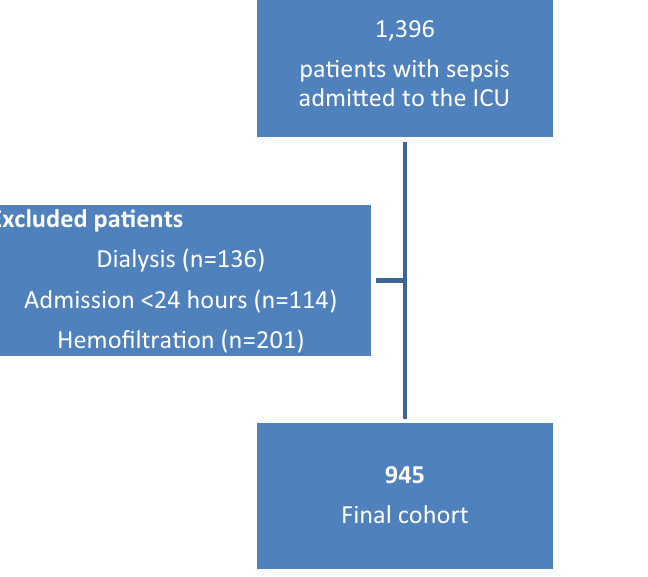
Figure 1. Flow chart – patient selection for this cohort.